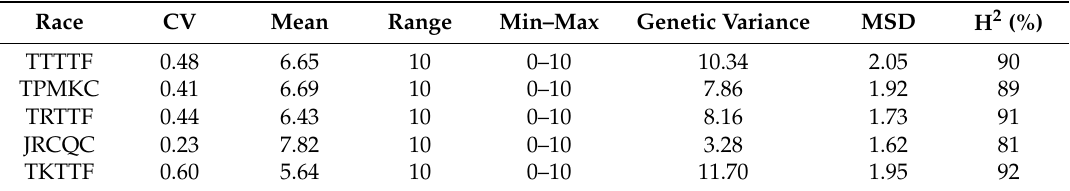
Table 1. Statistic parameters for reaction of a tetraploid wheat collection to five races of Puccinia graminis f. sp. tritici . CV: coefficient of variation; MSD: minimum significant difference; H 2 : heritability.